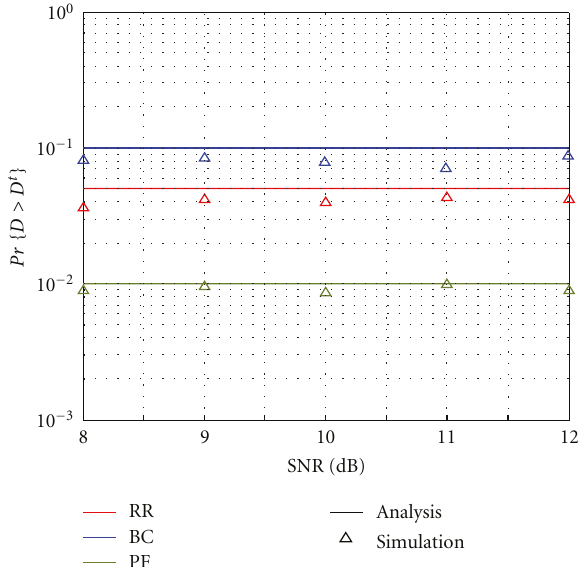
Figure 10: Simulation comparison for a time-correlated channel with exponential ACF of parameter ρ = 0 . 8. 5 users with γ = 8,9,10,11,12 dB, respectively. D t = 250 symbols. ε = 0 . 10 (RR), 0 . 05 (BC), and 0 . 01